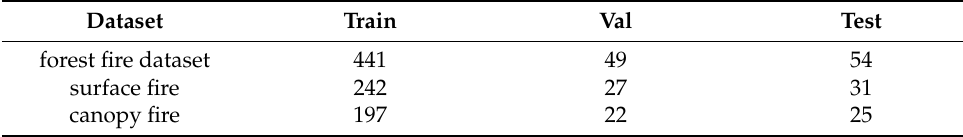
Table 3. Details of our